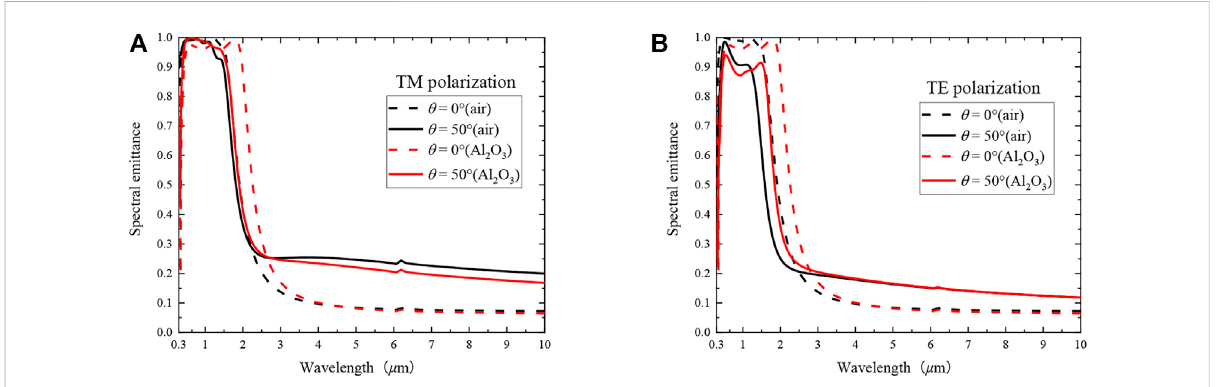
FIGURE 10 The spectral emittance for incident angles θ = 0 ° and θ = 50 ° when the incident waves (A) TM and (B) TE are polarized and the array cavity fi lling media are air and Al 2 O 3 , respectively.